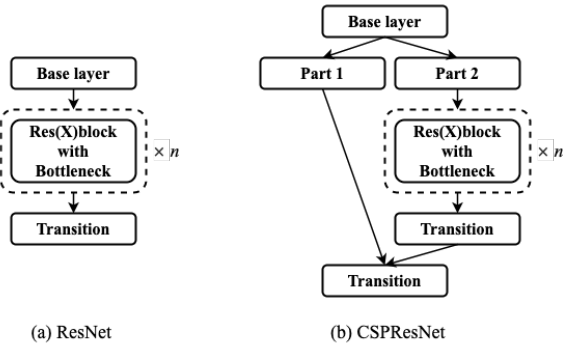
Figure 3. YOLOv3 and YOLOv4 feature fusion strategies: ( a ) ResNet for YOLOv3; ( b ) CSPResNet for YOLOv4.